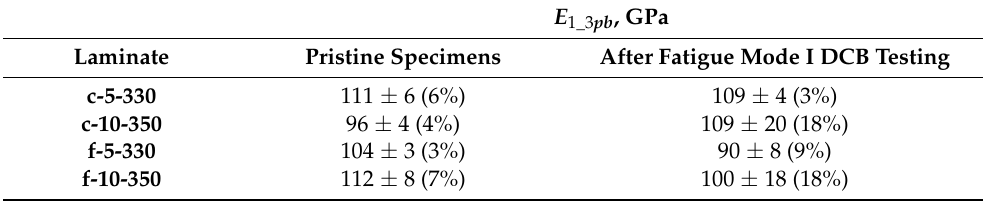
Table 2. The flexural moduli obtained from three-point bending tests performed on pristine DCB specimens and on specimens after fatigue mode I DCB testing. The values presented were calculated as the arithmetic mean of four pristine specimens for c-5-330; of five pristine specimens for c-10-350, f-5-330, and f-10-350; and of two specimens tested under fatigue for every laminate type.